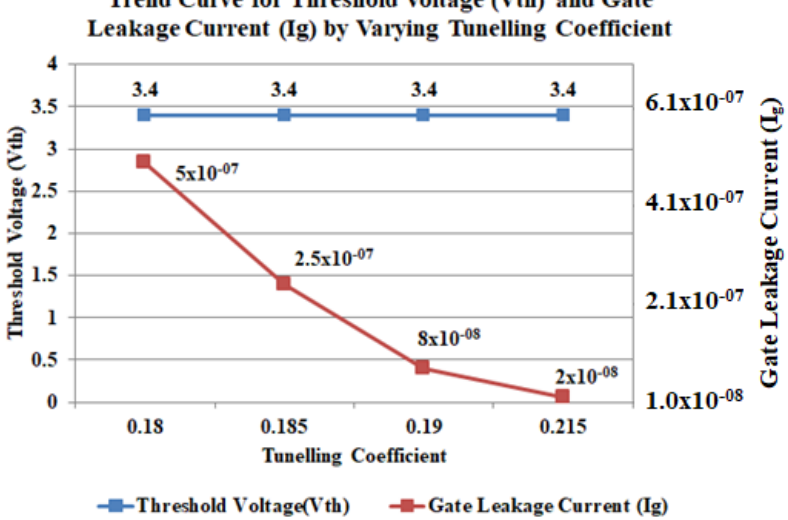
Figure 5. Simulated points on the impact of tunneling coefficient on threshold voltage ( V th ) and gate leakage current.